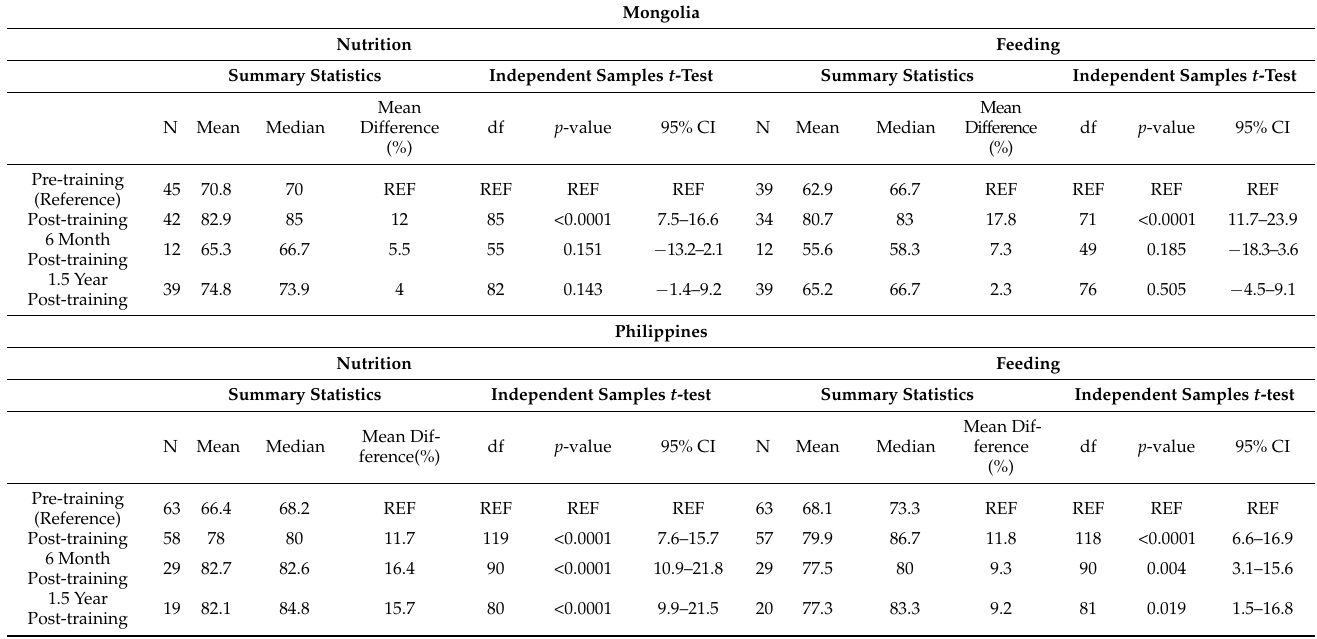
Table 1. Comparison of Unmatched Nutrition and Feeding Test Scores from Pre-training to Post- training, 6-month Post-training and 1.5-year Post-training using an Independent Samples t -test.